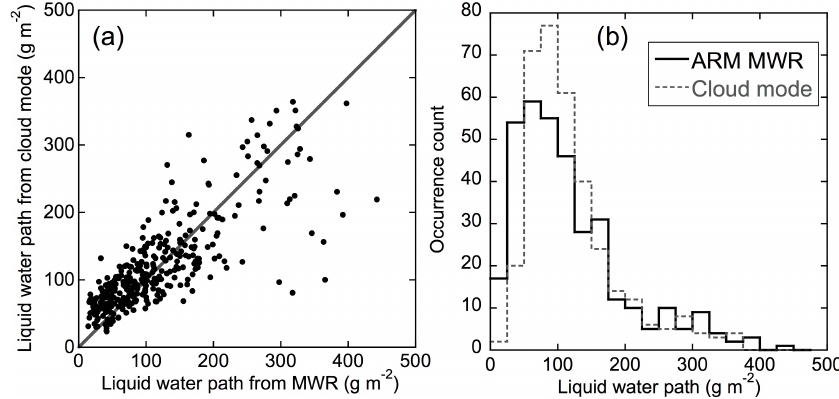
Fig. 8. (a) Scatter plot of liquid water paths retrieved from the ARM microwave radiometer (MWR; Turner et al., 2007) versus coincident cloud-mode measurements at 1.5-min temporal resolution for all liquid water clouds during May 2007–June 2008. Cloud-mode LWP values are calculated from retrieved cloud optical depth and effective radius, assuming that cloud droplet concentration is approximately constant and that liquid water content increases linearly with height. (b) The corresponding occurrence counts using a bin size of 25gm − 2 .